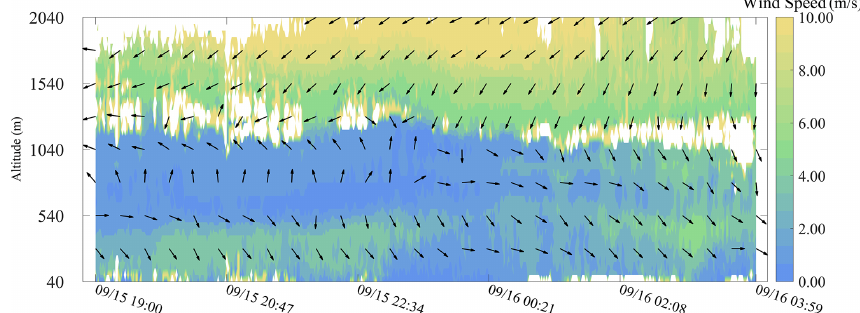
Figure 13. Wind speed and wind direction of Type